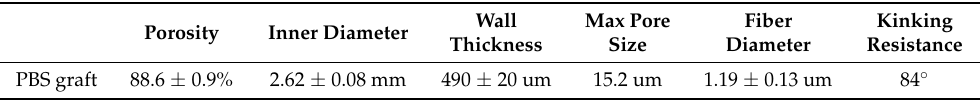
Table 1. Porosity, inner diameter, and wall thickness calculated from the uCT data, pore size and fiber diameter calculated from SEM and kink resistance.